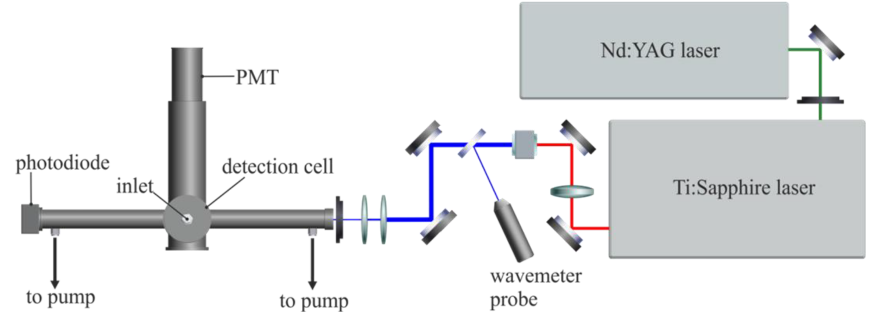
Figure 1. Plan view schematic of the glyoxal instrument, showing the arrangement of lasers, optics, and detection cell. Not shown is the delay generator, which controls the timing of the experiment, namely the firing of the laser pulse and also the collection windows of the photon counter, which measures both the phosphorescence signal and the background